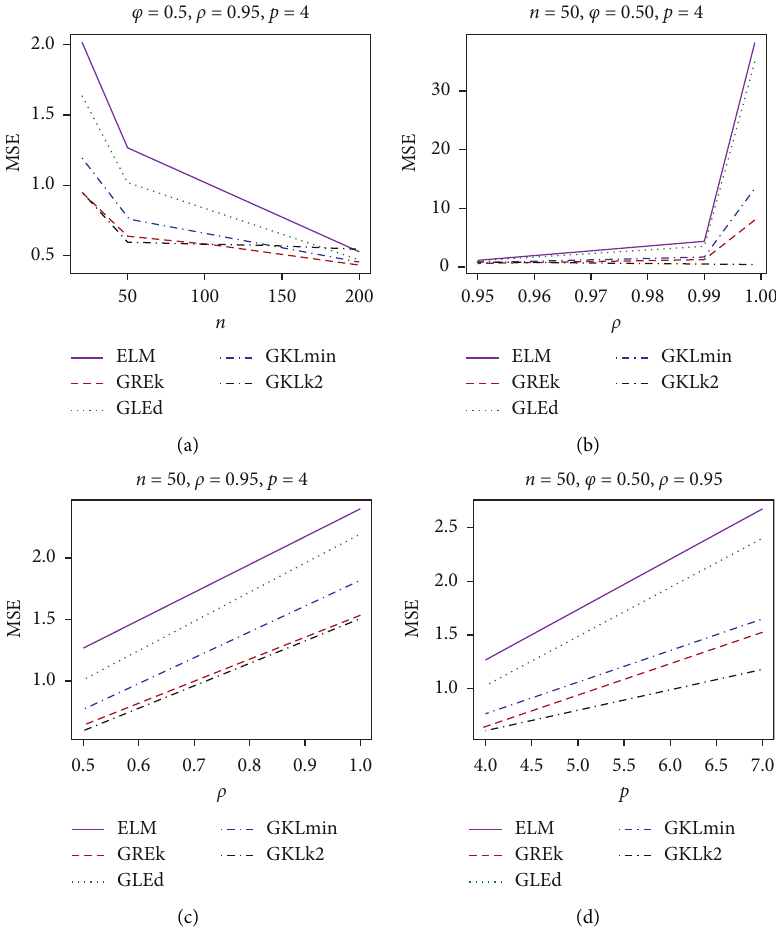
Figure 1: Estimated MSE vs. different values of (a) n , (b) ρ , (c) φ , and (d) p